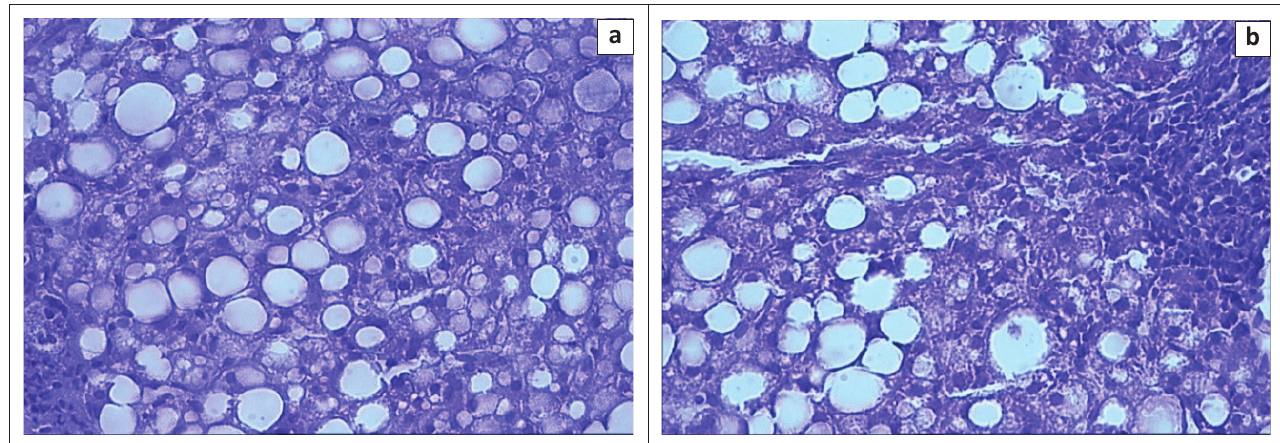
FIGURE 3: Sectioned slides. Macrovesicular globules of fat, inflammation in the area of the periportal tract, focal fibrosis (hematoxylin and eosin, ×